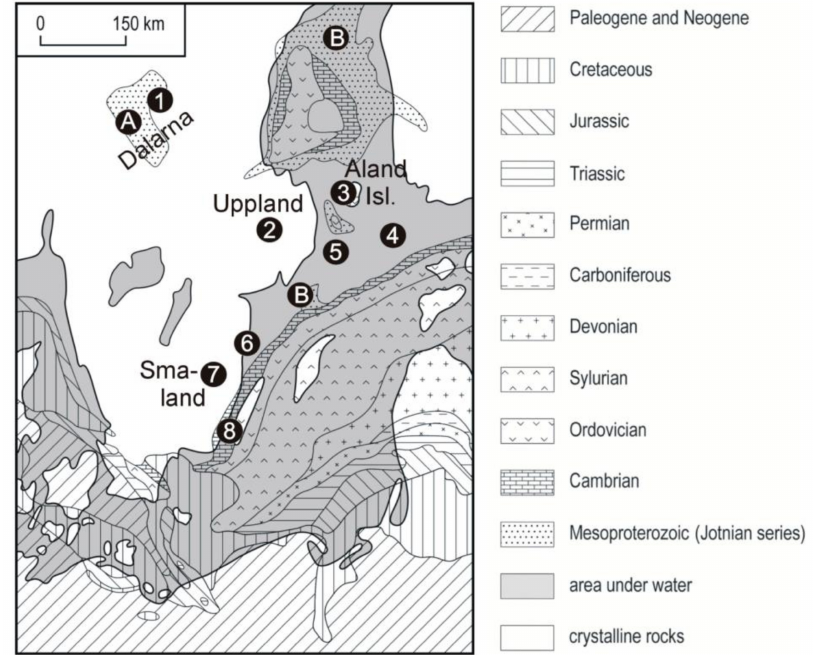
Figure 8. Location of the outcrops of indicator erratics, identified in the Łubienica-Superunki gravel pit, and symbolic location of the outcrops of erratics of limited indicative significance. Symbols of indicator erratics: 1—Bredvad porphyry, 2—Uppsala granite, 3—Åland quartz porphyry, 4—red Baltic porphyry, 5—brown Baltic porphyry, 6—Västervik porphyrite, 7—Småland granite, 8—Kalmar and Tessini sandstones. Symbols of erratics of limited indicative significance: A—Dalarna sandstone, B—Jotnian